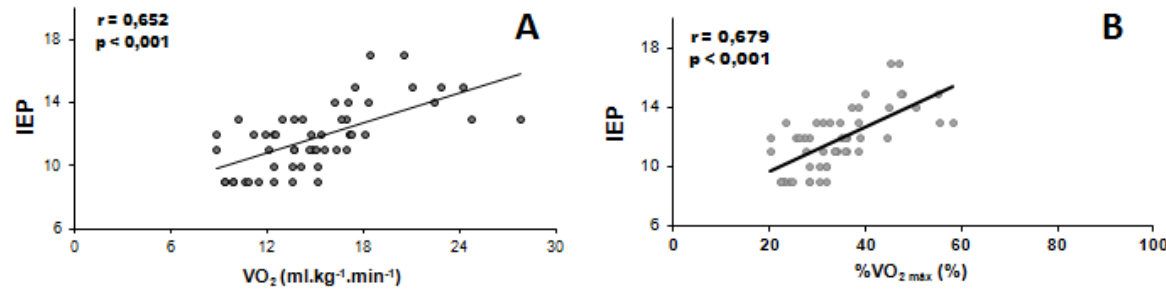
Figura 3. Correlações entre consumo de oxigênio (VO percentual do consumo de oxigênio máximo de (%VO